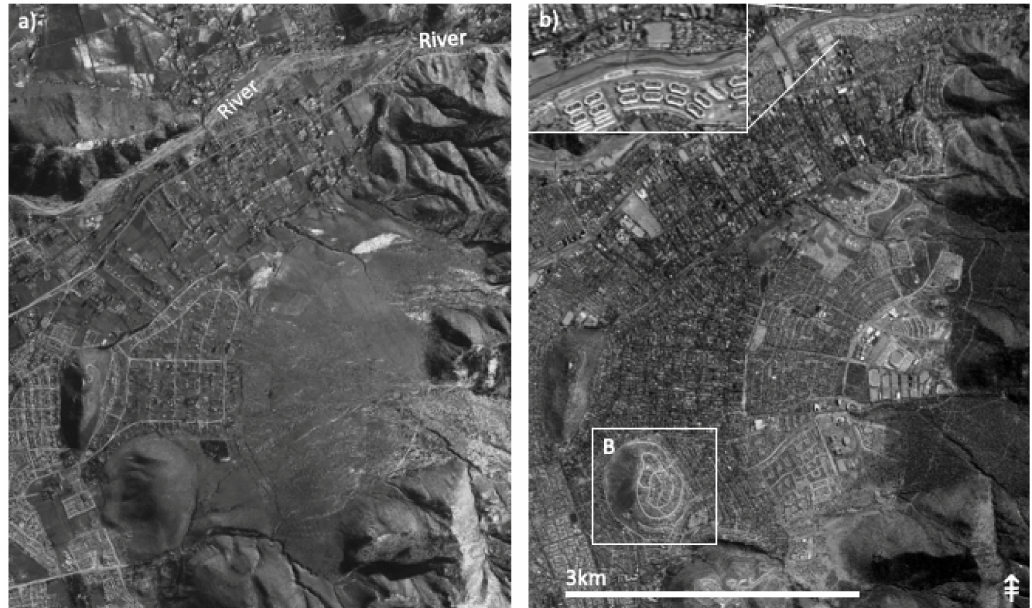
Figure 3. Santiago de Chile, Chile. Area east of city centre in ( a ) 1972 and ( b ) 2006, showing urban growth into bordering mountainous area. Inlet in ( b ) shows trained river area, and the white box B indicates the location of Figure 4. (Data: Table 3).